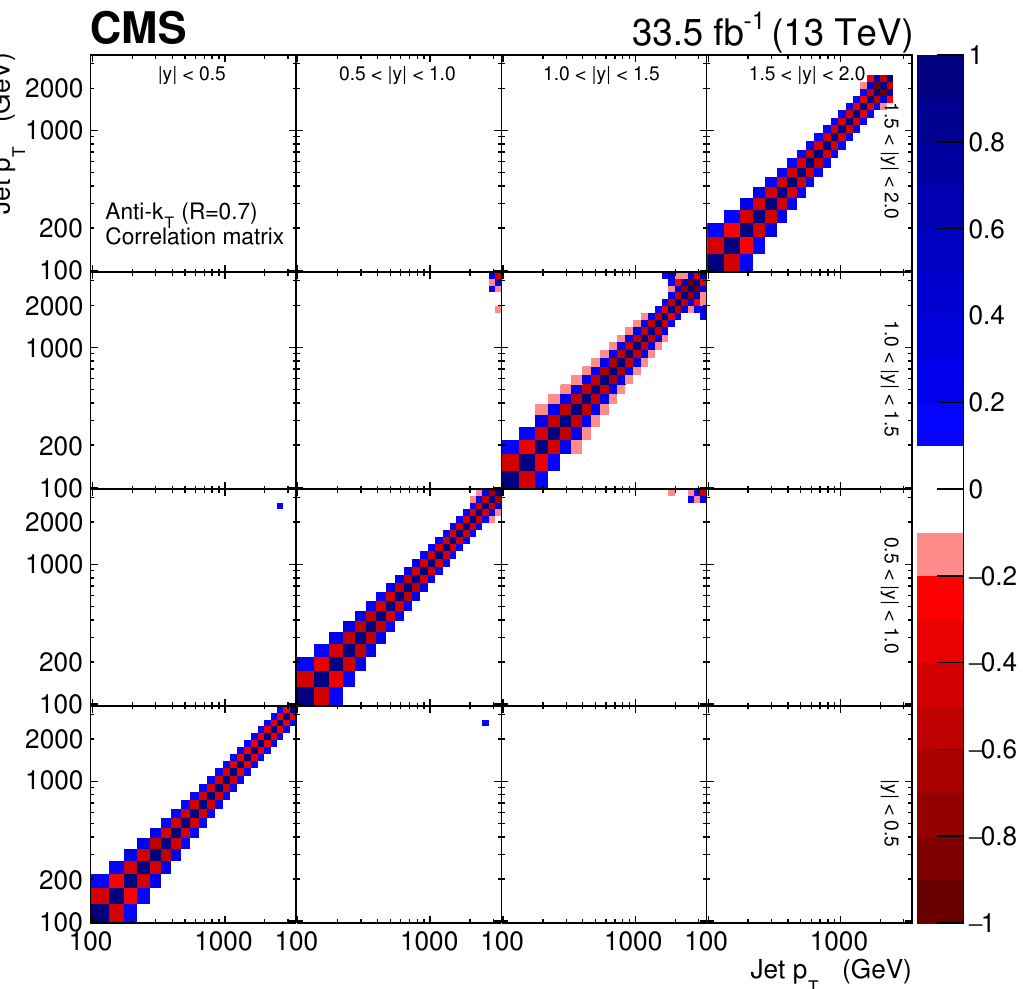
algorithm Figure 3 . The correlation matrix at the particle level, for jets clustered using the anti- k T with R = 0 . 7 . It contains contributions from the data and from the pythia 8 sample used to perform the unfolding. The global 4 × 4 structure corresponds to the bins of rapidity y of the jets, indicated by the labels in the uppermost row and rightmost column; the horizontal and vertical axes of each cell correspond to the transverse momentum p of the jets. The colour range covers a range from T − 1 to 1 and indicates correlations in blue shades and anti-correlations in red shades, except for values between − 0 . 1 and 0.1. Correlations across rapidity bins reach significant values mostly at the edges of the p T